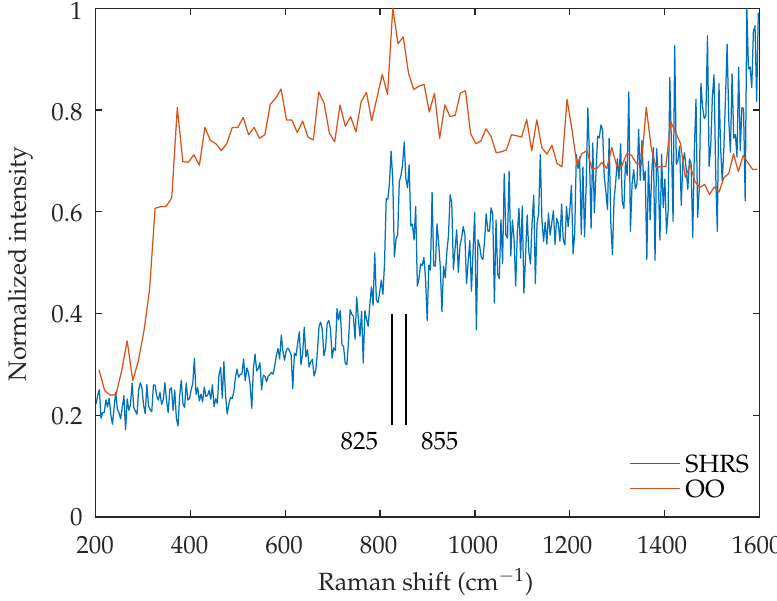
Figure 13. Raman spectrum of forsterite (Mg 2 SiO 4 ), obtained from the nickel ore. The obtained SNR from SHRS for each band at 825 and 855 cm − 1 is approximately 20. These two bands were not resolved by the dispersive spectrometer. The SNR from the dispersive spectrometer for the range covering these bands was approximately